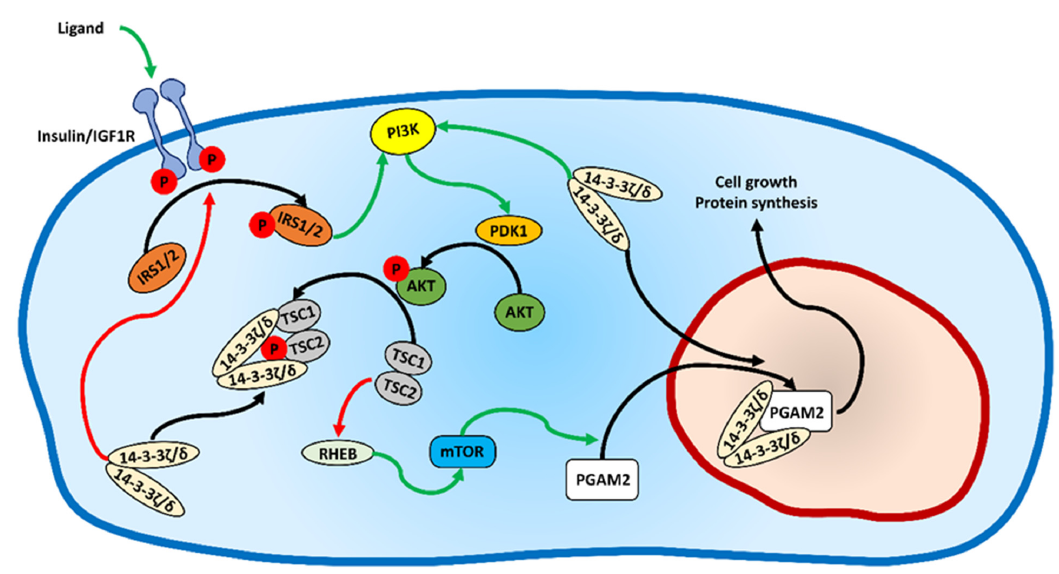
Figure 8. Schematic representation of the insulin/IGF1R–PI3K–AKT–mTOR signaling pathway and its impact on the subcellular distribution of PGAM2. The regulatory function of 14-3-3 ζ / δ on the pathway is also included in the scheme. Arrows: green—activation; red—inhibition; black—trans-location/targeting.